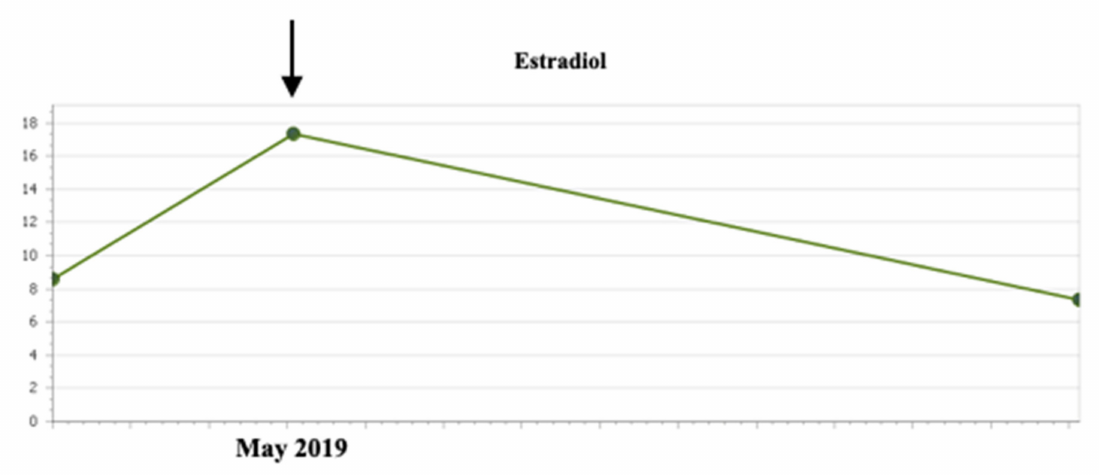
Figure 2. Evolution of FSH and LH values before and after starting hormone treatment (July 2019).